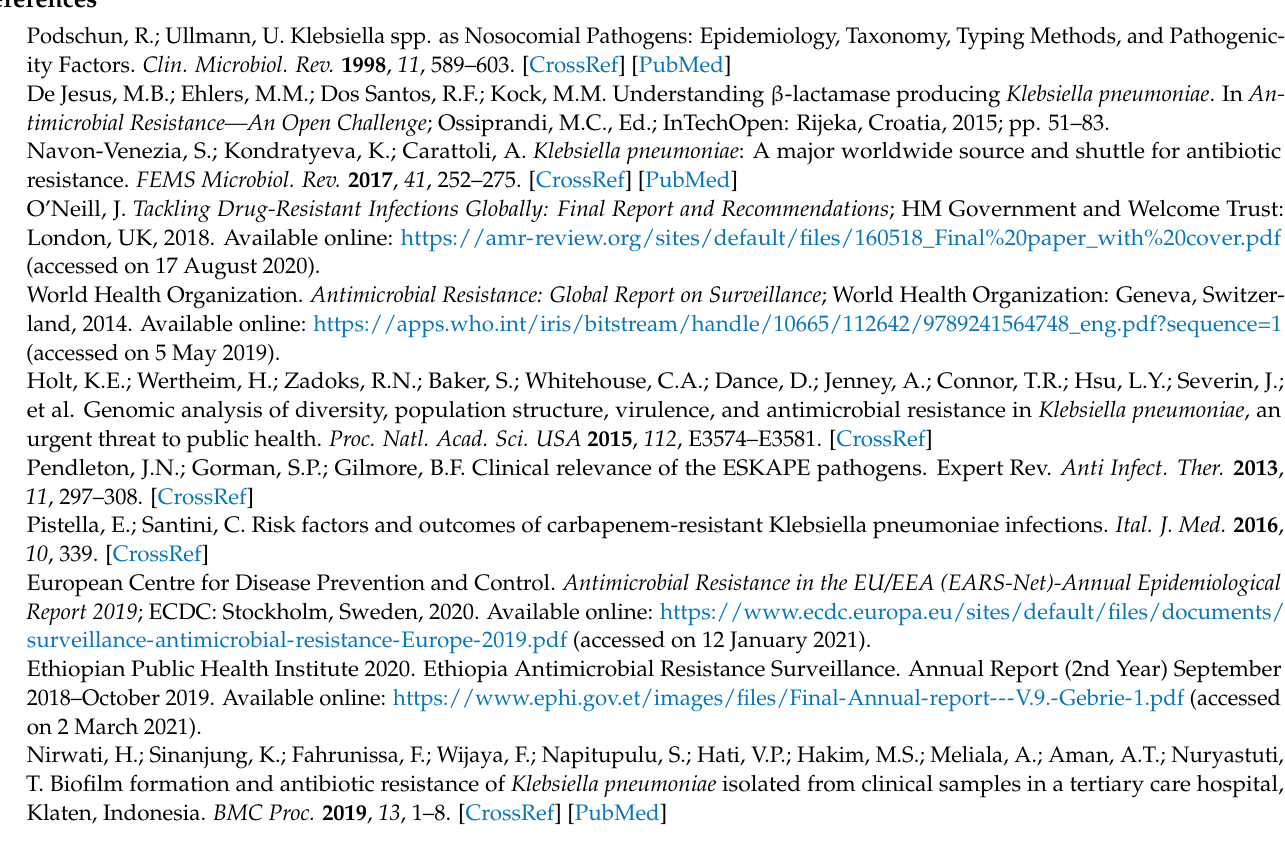
Table S1: Previous antimicrobial treatment status of study participates ( n =